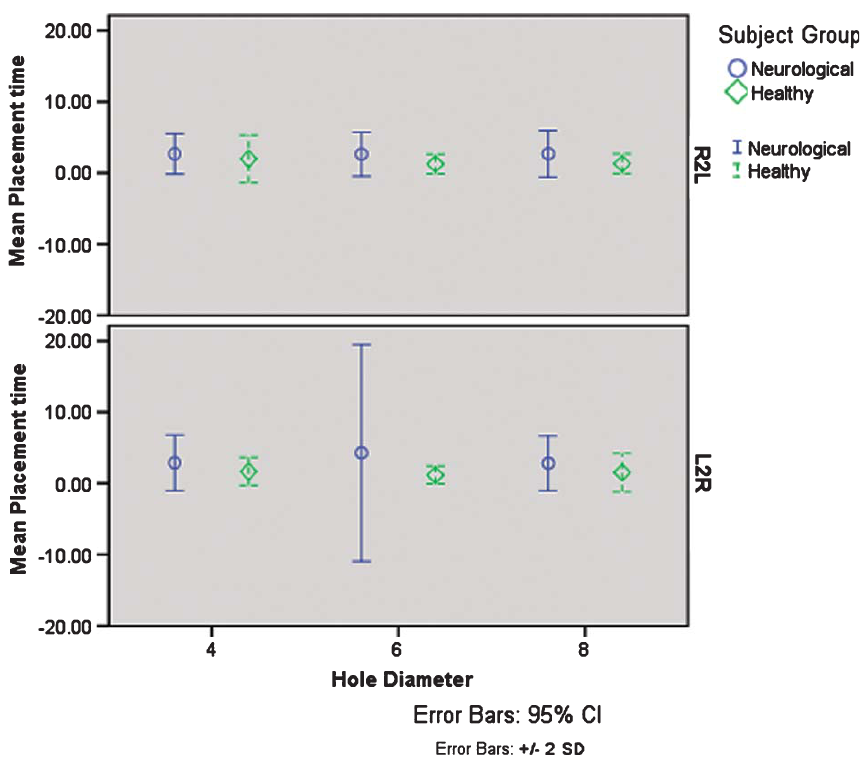
Fig. 6. Comparing placement time for R2L and L2R half cycles and subject